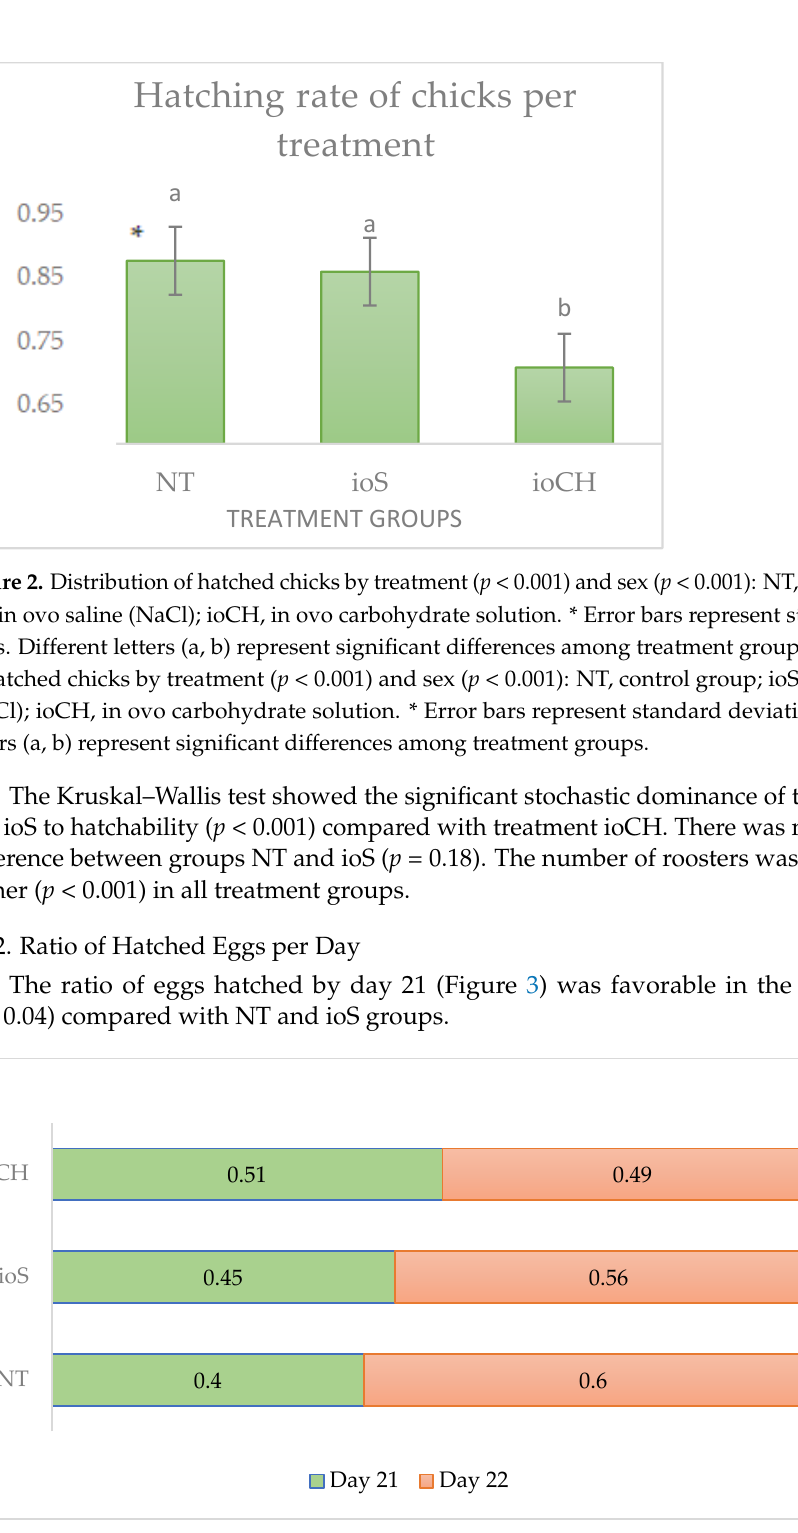
Figure 1. Distribution of hatched chicks by treatment ( p < 0.001) and sex ( p < 0.001): NT, control group; ioS, in ovo saline (NaCl); ioCH, in ovo carbohydrate solution. Different letters (a, b) repre-